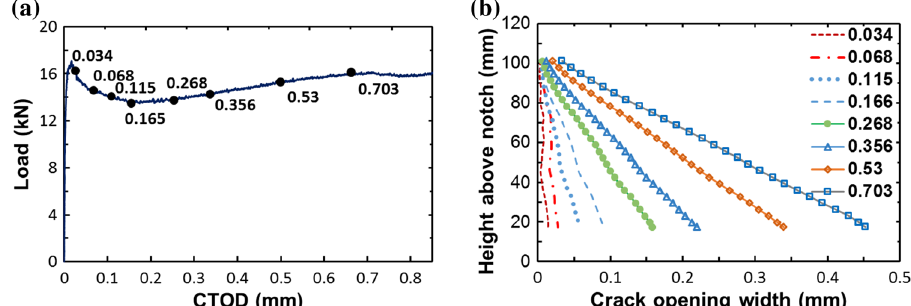
Fig. 11 Results from an SFRC75 specimen: a load-CTOD response of a typical specimen; b crack opening width as a function of height above the notch for different values of CTOD (in mm).